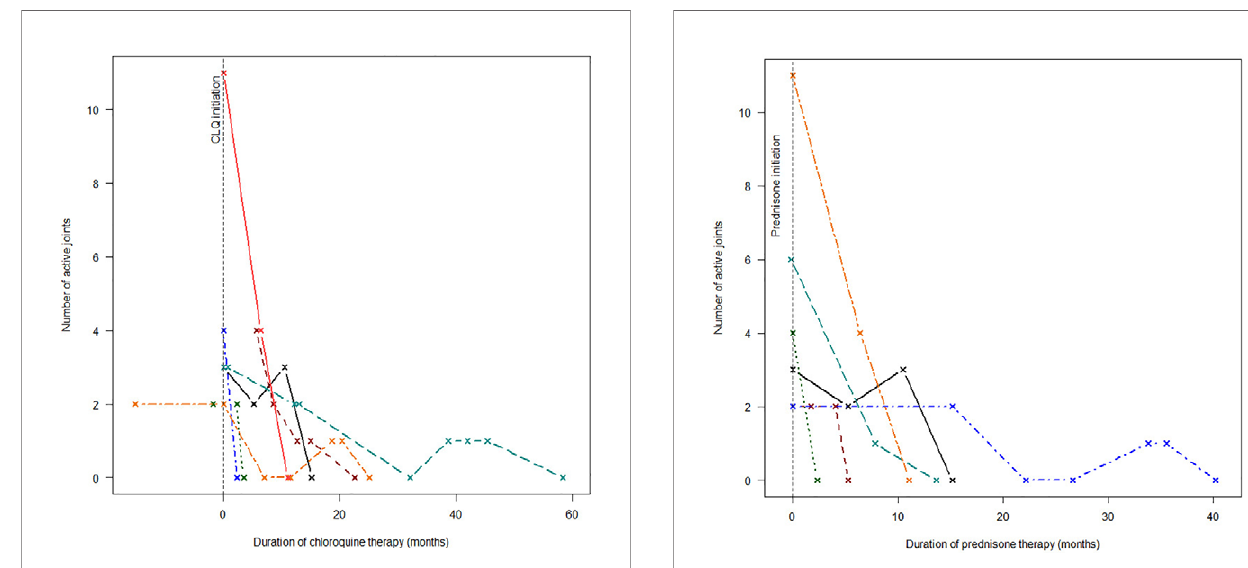
FIGURE 4 | Response to prednisone